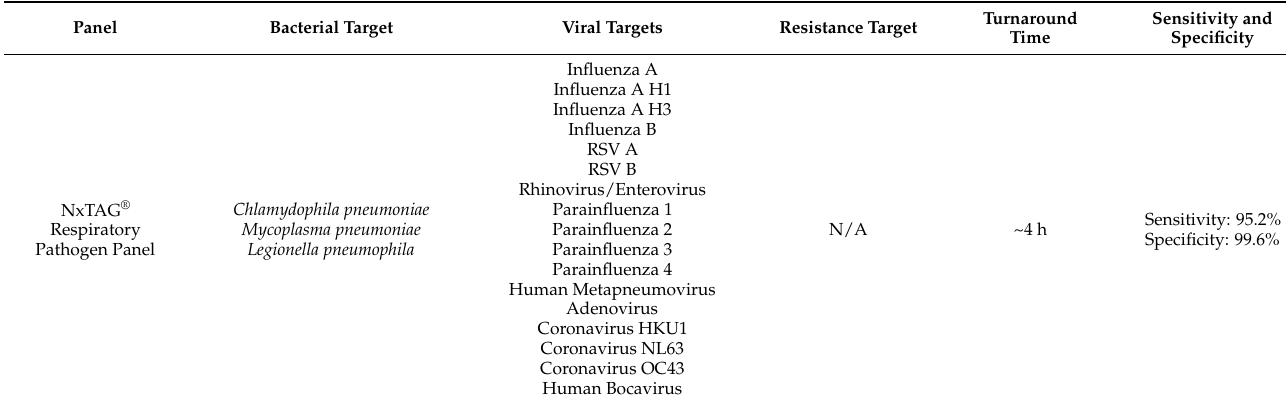
Table 3. Comparison of Various Rapid Respiratory Panels Continued [58].